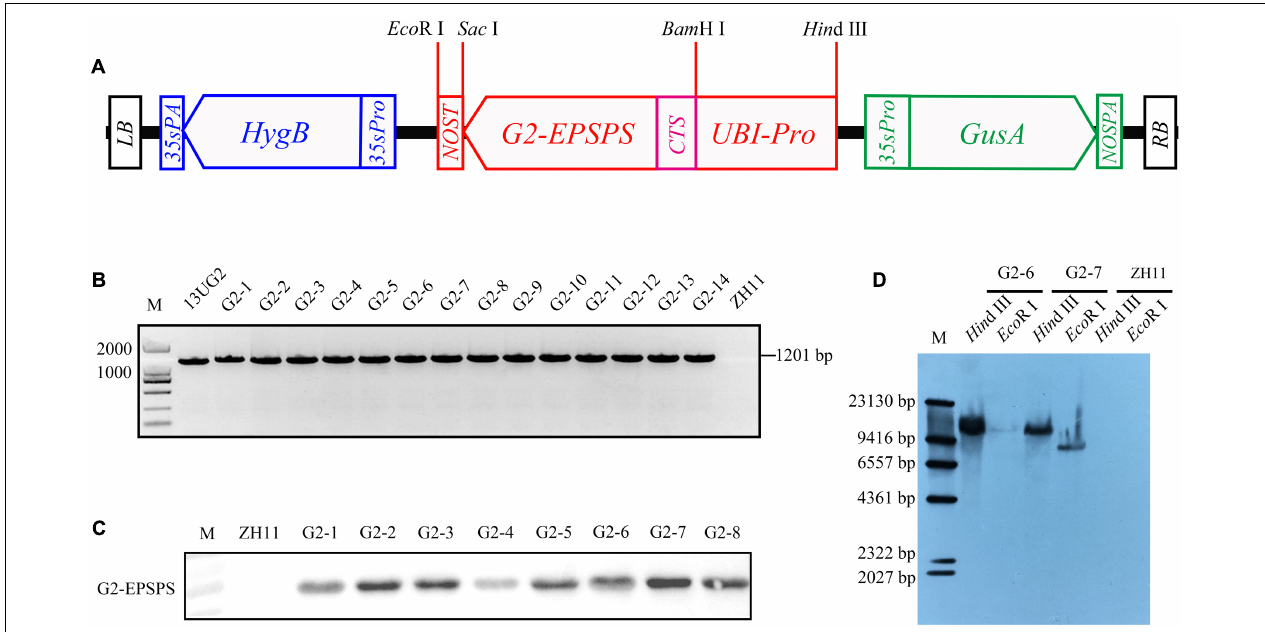
FIGURE 1 | Transformation and detection of transgenic rice. (A) Diagrams of the plasmid constructs UBI::CTS::G2-EPSPS , containing the CTS::G2-EPSPS coding region with a nos terminator under control of the UBI promoter. (B) The transgenic-line-specific PCR was implemented using G2-EPSPS gene-specific primers. The vector 13UG2 was used as the positive control (lane 13UG2 ), and ZH11 DNA was used as the negative control (lane ZH11). (C) Expression analysis of the G2-EPSPS protein in the shoot of ZH11 (designated as negative control) and eight UBI::CTS::G2-EPSPS T0 transgenic lines (G2-1, G2-2, G2-3, G2-4, G2-5, G2-6, G2-7, G2-8). (D) Transgenic rice genome DNA was digested with restriction endonuclease Hin dIII and Eco RI. The DIG-labeled G2-EPSPS gene probe was used to detect T-DNA copy number in transgenic